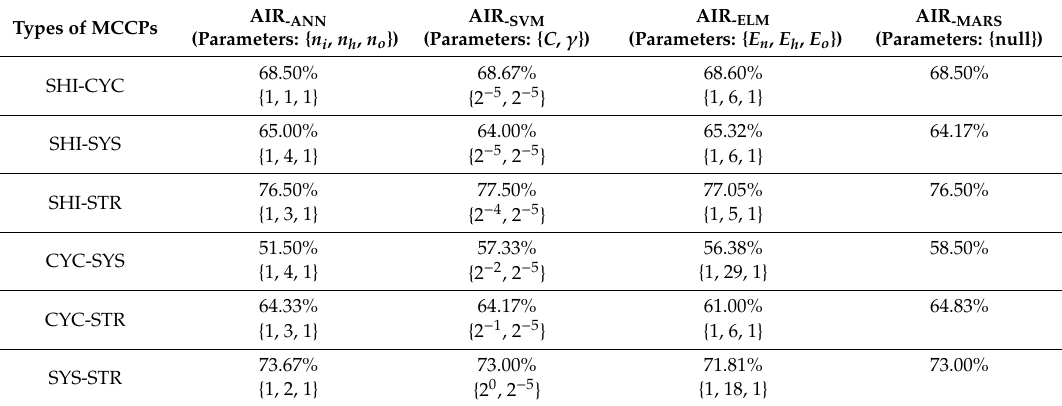
Table 2. Results of MCCP recognition for two process outputs (first scheme: without the use of EPC). Types of